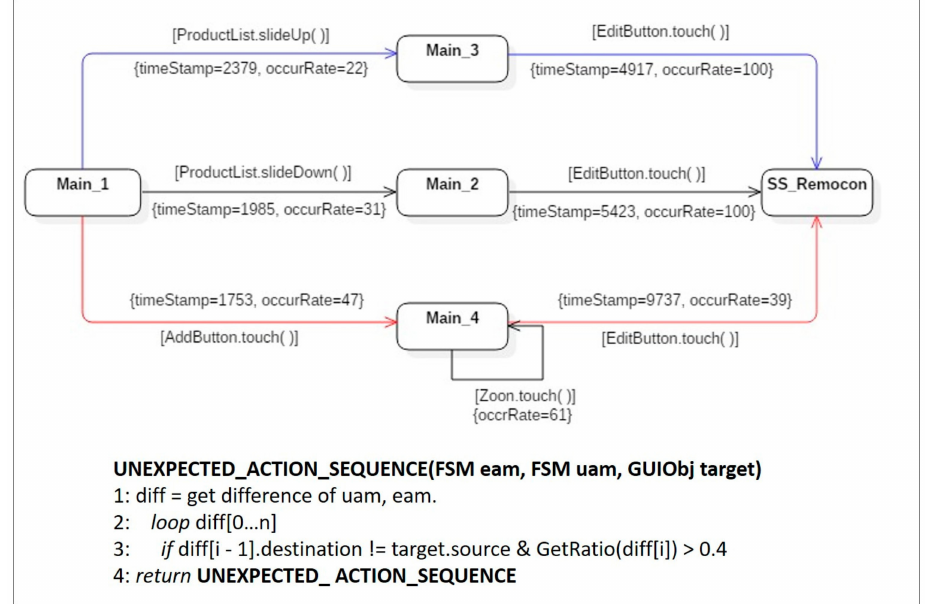
Figure 9. An instance of a user activity model, including bad symptom type